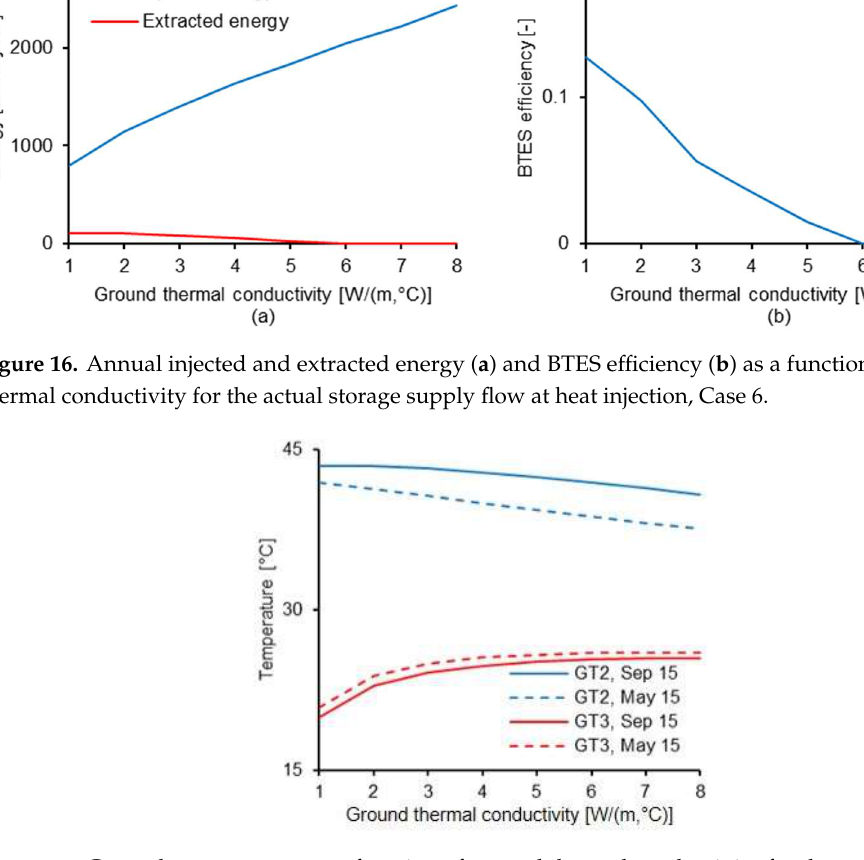
Figure 17. Ground temperatures as a function of ground thermal conductivity for the actual storage supply flow at heat injection, Case 6. September 15 and May 15 are the start and end of the building heating season respectively.